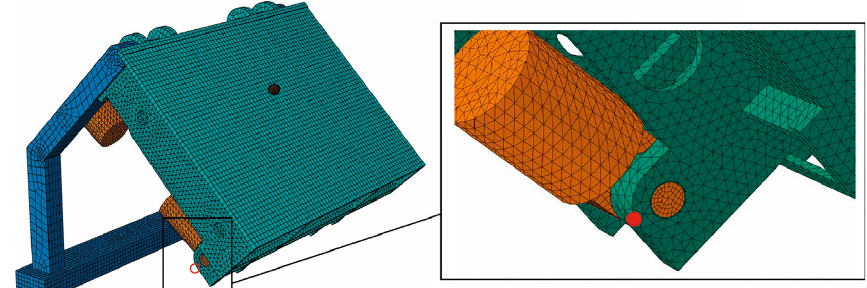
Figure 11: Position of the selected rigid node on the tail beam.